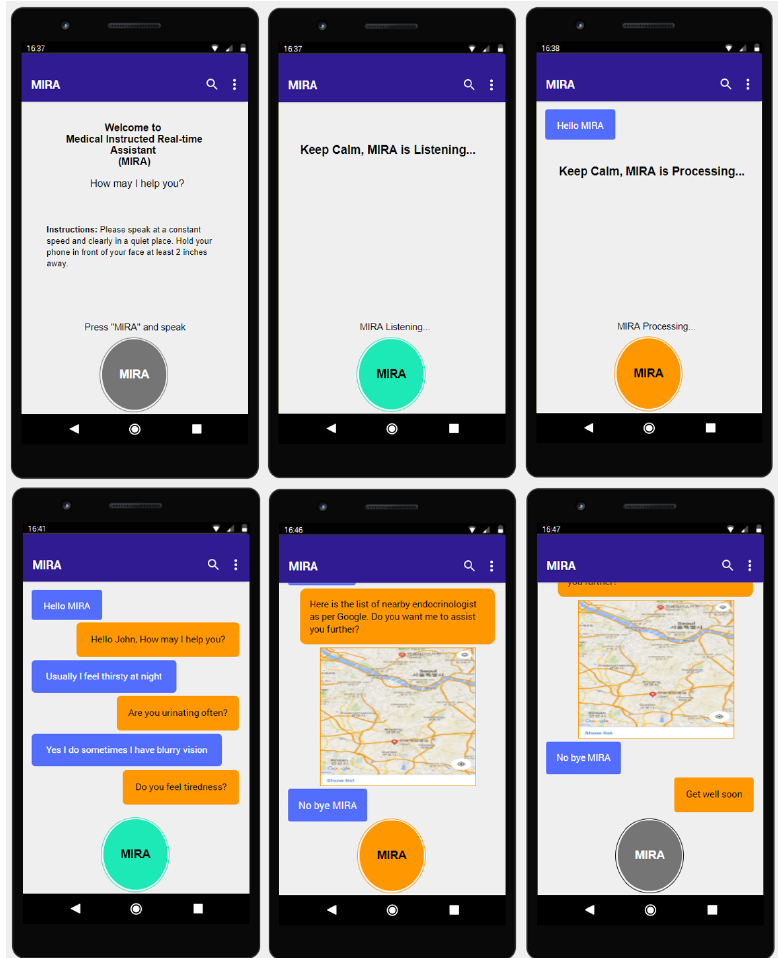
Figure 5. MIRA smartphone application screenshot on android